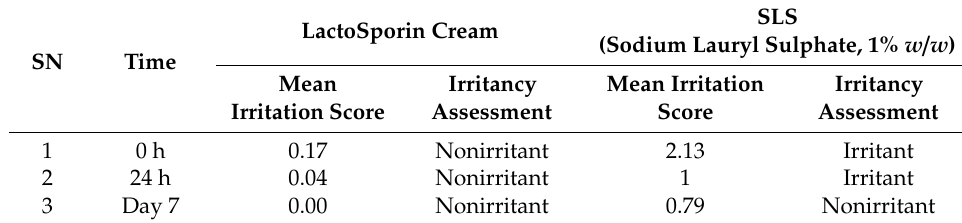
Table 1. Primary skin irritation test of LactoSporin cream.